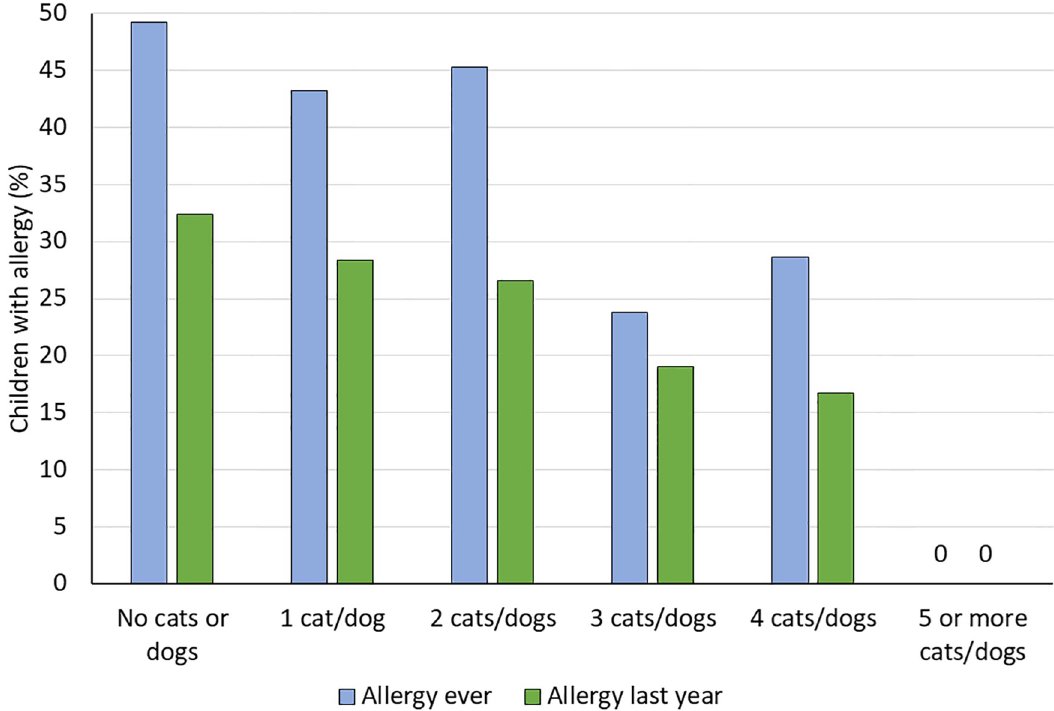
Fig 1. Data from the cross-sectional study. Allergy (any of asthma, allergic rhinoconjunctivitis, or eczema) in relation to the number of household cats and dogs during the child’s first year of life. Allergy last year required current symptoms, i.e. symptoms in the last 12